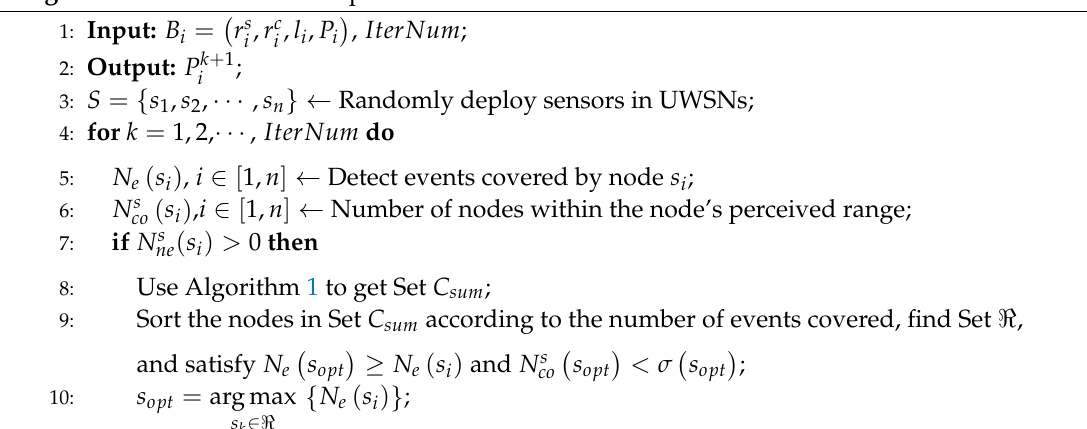
Algorithm 2: DHFSOA Description